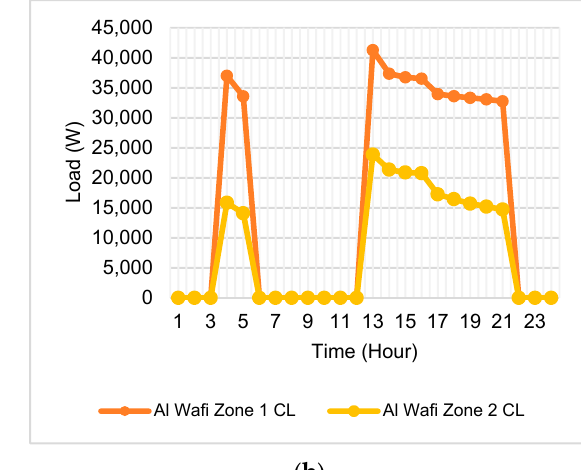
Figure 17. ( a ) Loads breakdown in Al Wafi mosque (Zone 1) during day 179 (summer); ( b ) loads breakdown in Al Wafi mosque (Zone 2) during day 179 (summer). It was noticed that Zone 2 is more affected by solar gain than Zone 1. This is due to the incidence of sunlight that directly affects the east and west walls during the summer. Zone 2 ′ s east wall is mostly exposed to sunlight between 7:00 and 12:00 and has a glazing ratio of 13.65%. Zone 1 ′ s west wall is exposed to sunlight between 12:00 and 19:00, and it has a glazing ratio of 3.86% in the west wall. Hence, Zone 1 is less affect by solar gain than Zone 2. Building heat transfer also impacts Zone 2 more than Zone due to the building envelope of both zones. The walls of the mosque are all thick clay walls that varies be ‐ tween 500 and 1200 mm, except for the east wall of Zone 2 which is 15 ‐ milimetre alumin ‐ ium partition wall. This wall was added during the 2000s to close Zone 2, which was pre ‐ viously a Riwaq (an arcade). Zone 2 east wall would allow more heat to be transferred from than other walls due to its higher U ‐ value of 7.27 W/m2.K compared to 0.7 W/m2.K U ‐ value for clay wall.